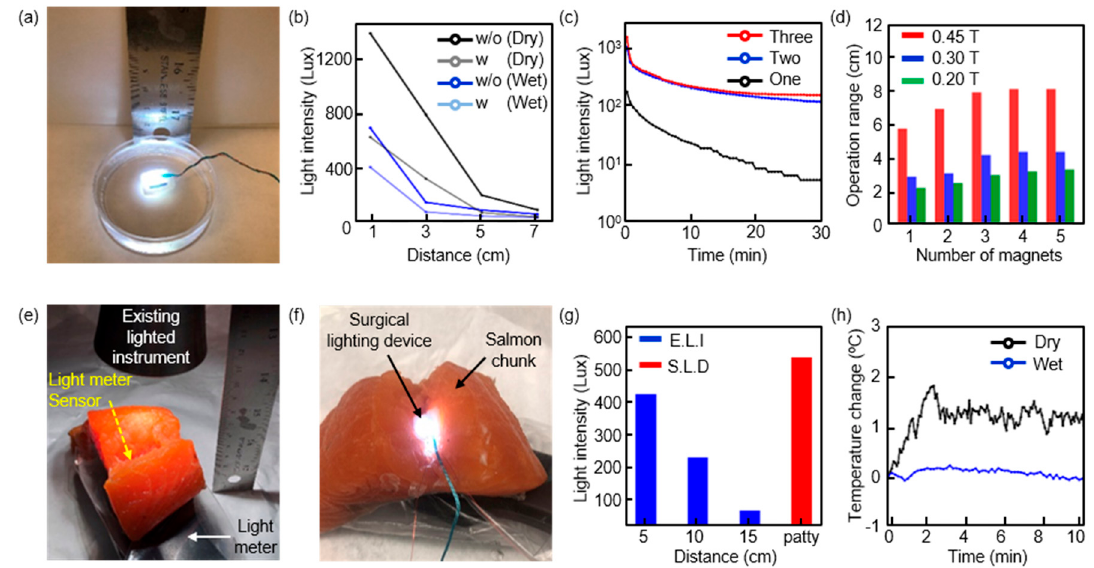
Figure 4. Demonstration of a surgical lighting patty in a biofluidic environment and assessment of its characteristics. ( a ) Picture of an experimental setup for light intensity measurement. Here, a patty is immersed in saline solution. ( b ) Plot of light intensity of surgical lighting devices as a function of distance from the device. ( c ) Plot of light intensity of the device as a function of time. Here, a set of batteries up to three with a capacity of 11 mAh are connected in series. ( d ) Dynamic range of wireless operation. The results indicate the effective range at which a reed switch in the surgical lighting patty is activated by magnets. Threshold for an activation of a reed switch is 4mT. Pictures of experimental setup for light intensity measurement of existing lighted instruments ( e ) and the surgical lighting device (S.L.D) ( f ). ( g ) Comparisons of light intensity with existing lighting instruments (E.L.I). ( h ) Thermal assessments of the surgical lighting patty.